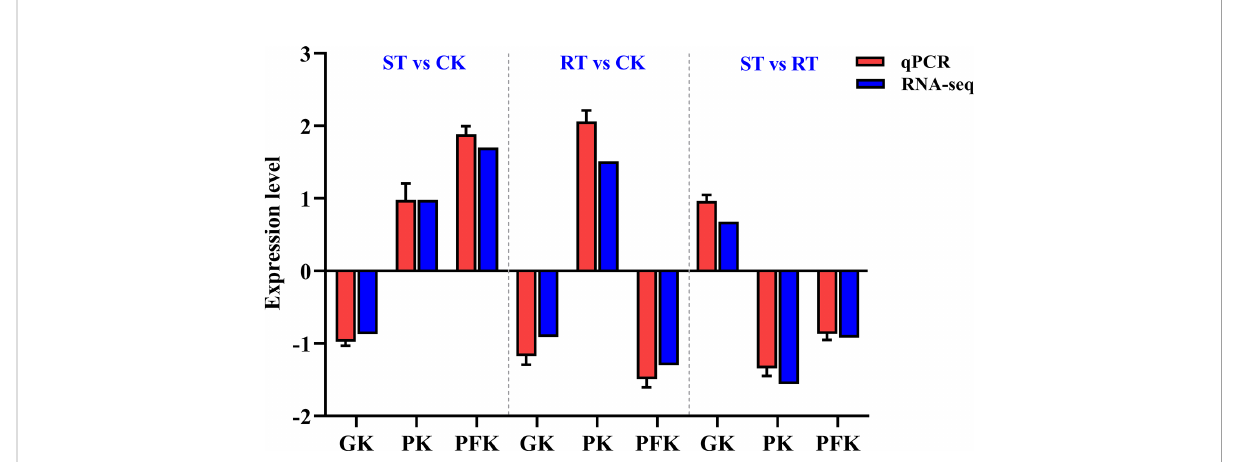
FIGURE 7 Comparison of gene expression between RNA-seq and quantitative real-time PCR (qRT-PCR)